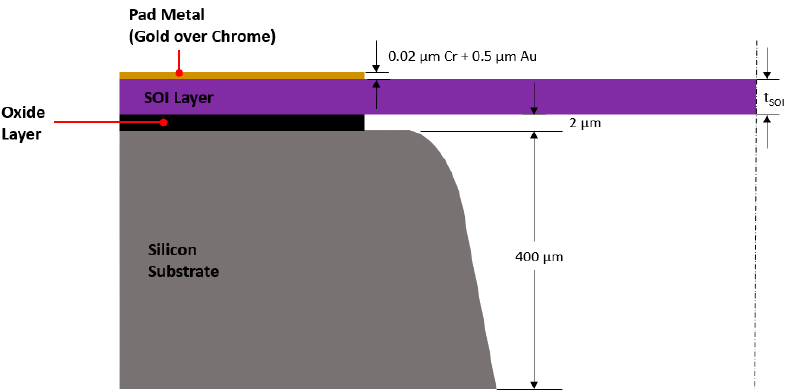
Figure 3. Section view of a SOIMUMPS structure exhibiting a process stack (not to scale). Figure based on procedures described in [3,15]. Table 1. Nominal geometric parameters of the MEMS structure (see Figure 2a for annotations).